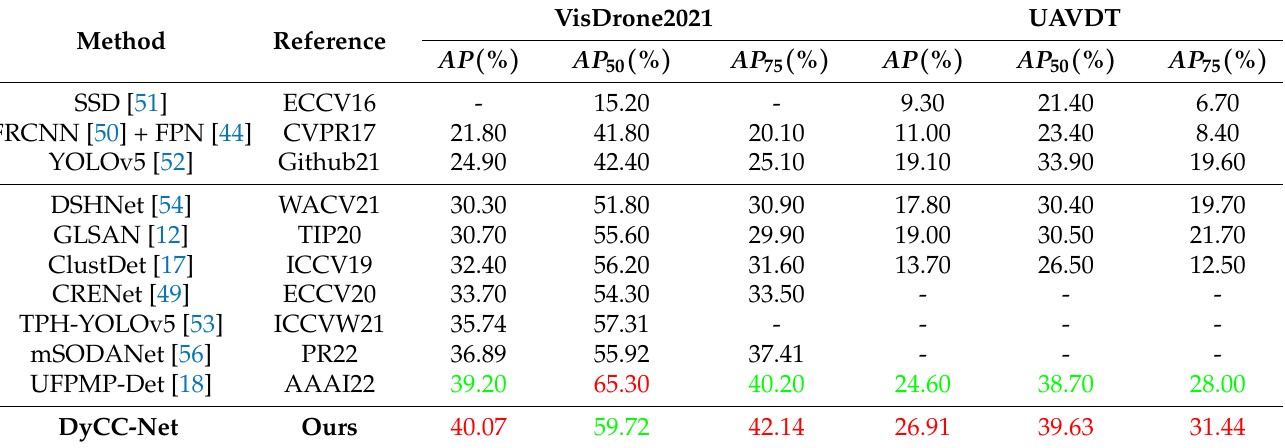
Table 5. Comparison of DyCC-Net with the SOTA models on UAVDT and VisDrone2021 datasets. ‘-’ denotes that the corresponding experimental statistics are not available. We highlight the top two results in red and